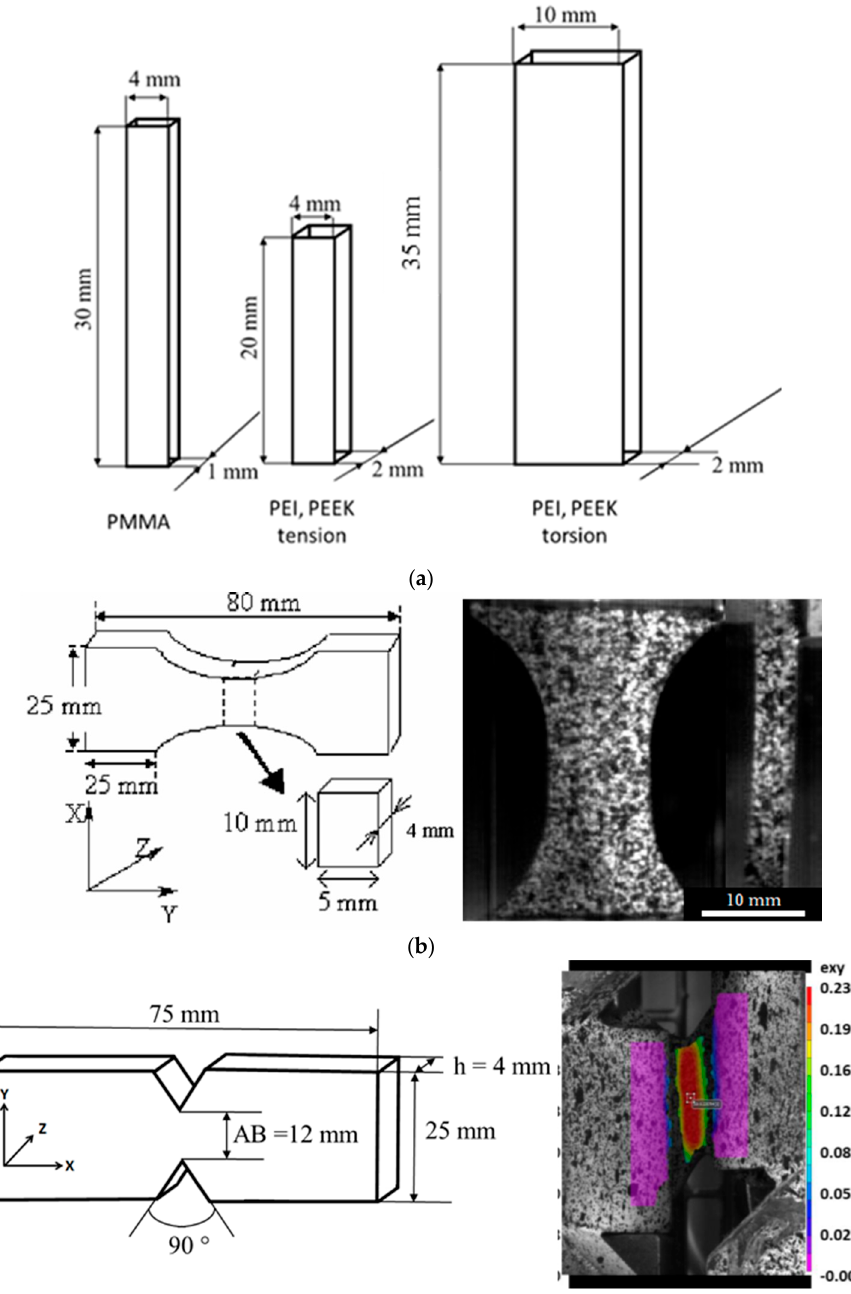
Figure 9 . Samples of geometries and dimensions: ( a ) DMA samples; ( b ) tensile specimen and image showing the random pattern (face and the thickness); ( c ) shear sample and strain (the square represents the zone of interest for which the stress and strain were estimated).